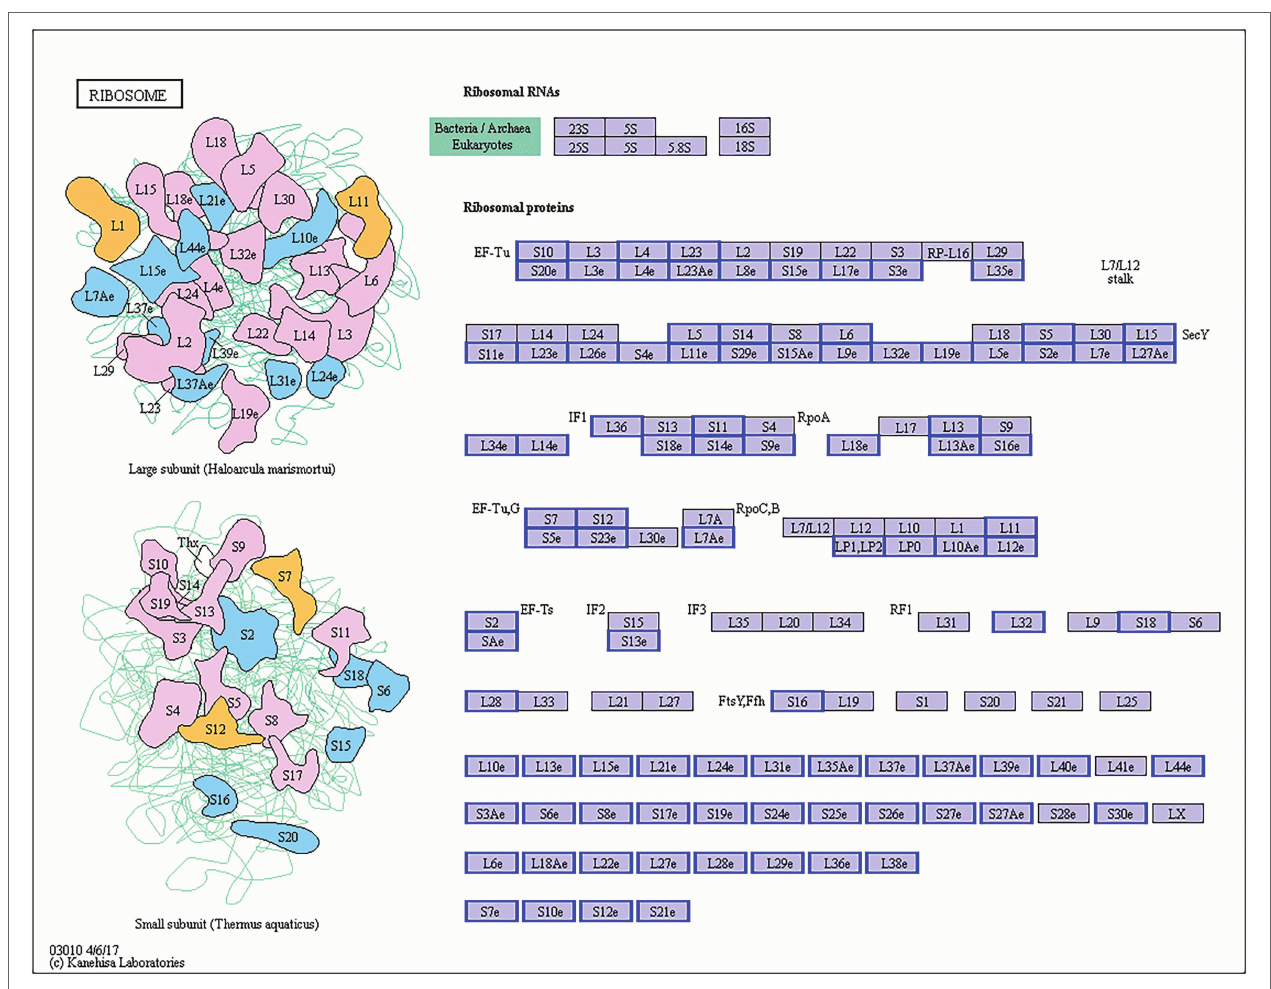
FIGURE 8 | S. sclerotiorum differentially expressed genes (DEGs) in ribosome (ko03010) KEGG pathway. The genes with red/blue border in the figure were DEGs identified by dual RNA sequencing analysis, where red represents up-regulated genes and blue represents down-regulated